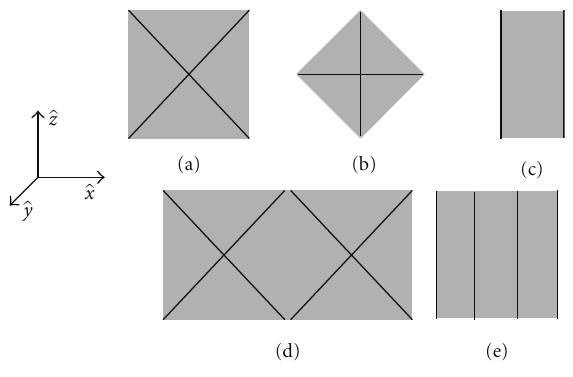
Figure 5: Schemes of Antenna